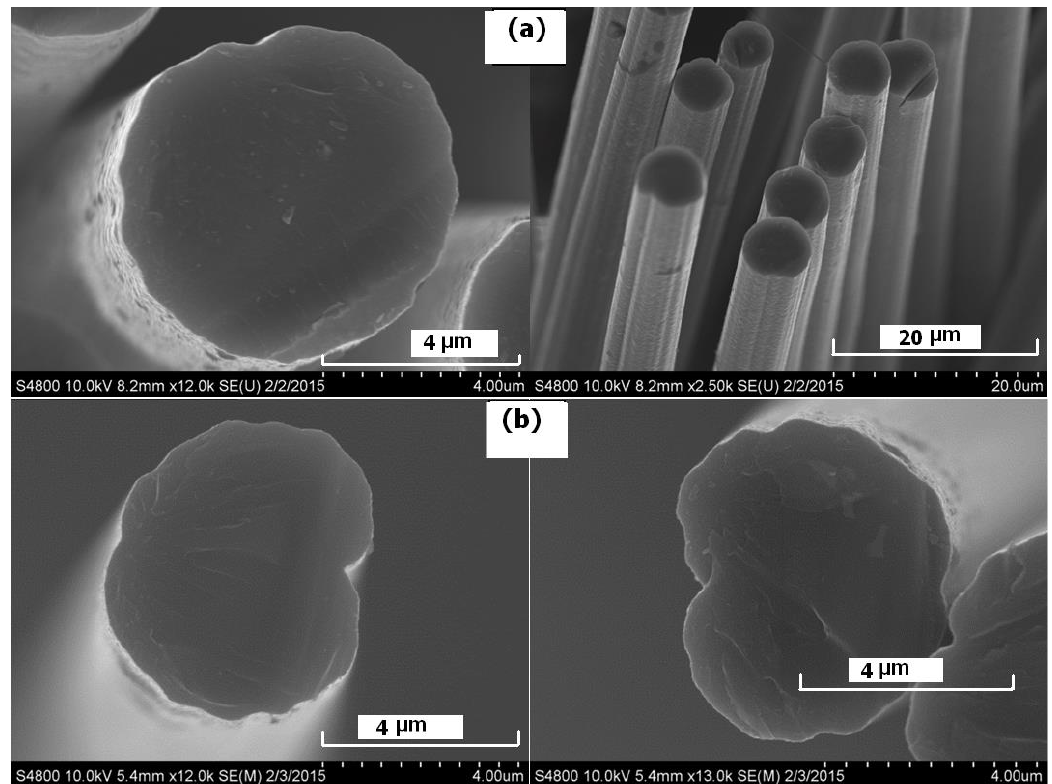
Figure 10. Carbonized Ace-SKL fibers from ( a ) UV/thermal dual stabilization ( b ) slow thermal